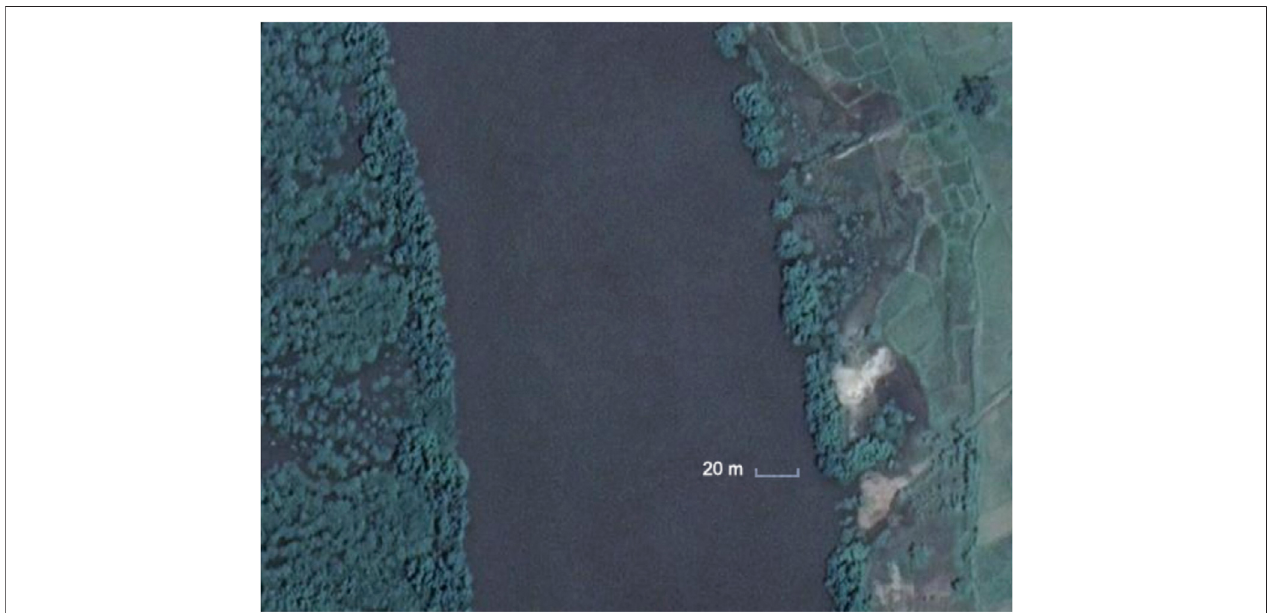
FIGURE 5 | Illustration of small mangrove patches less than 30 m × 30 m in the study area.